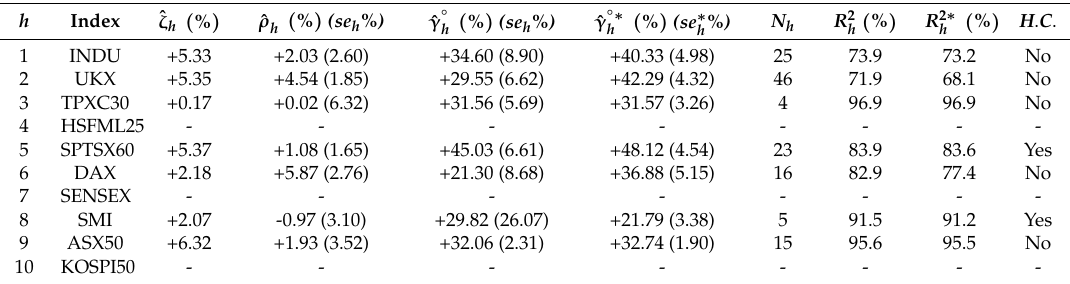
Table 3. Regression Results (Equation (7)):